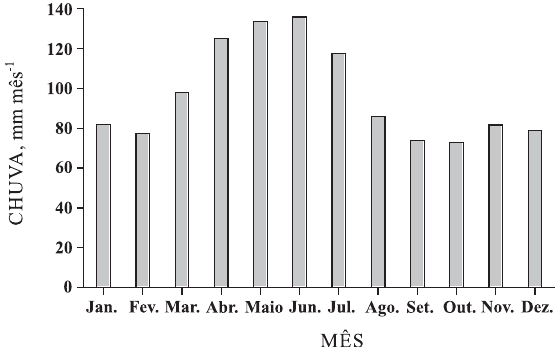
(BA).Figura 1. Dados de precipitação pluviométrica na região de Sapeaçu (BA), média de 1971 a